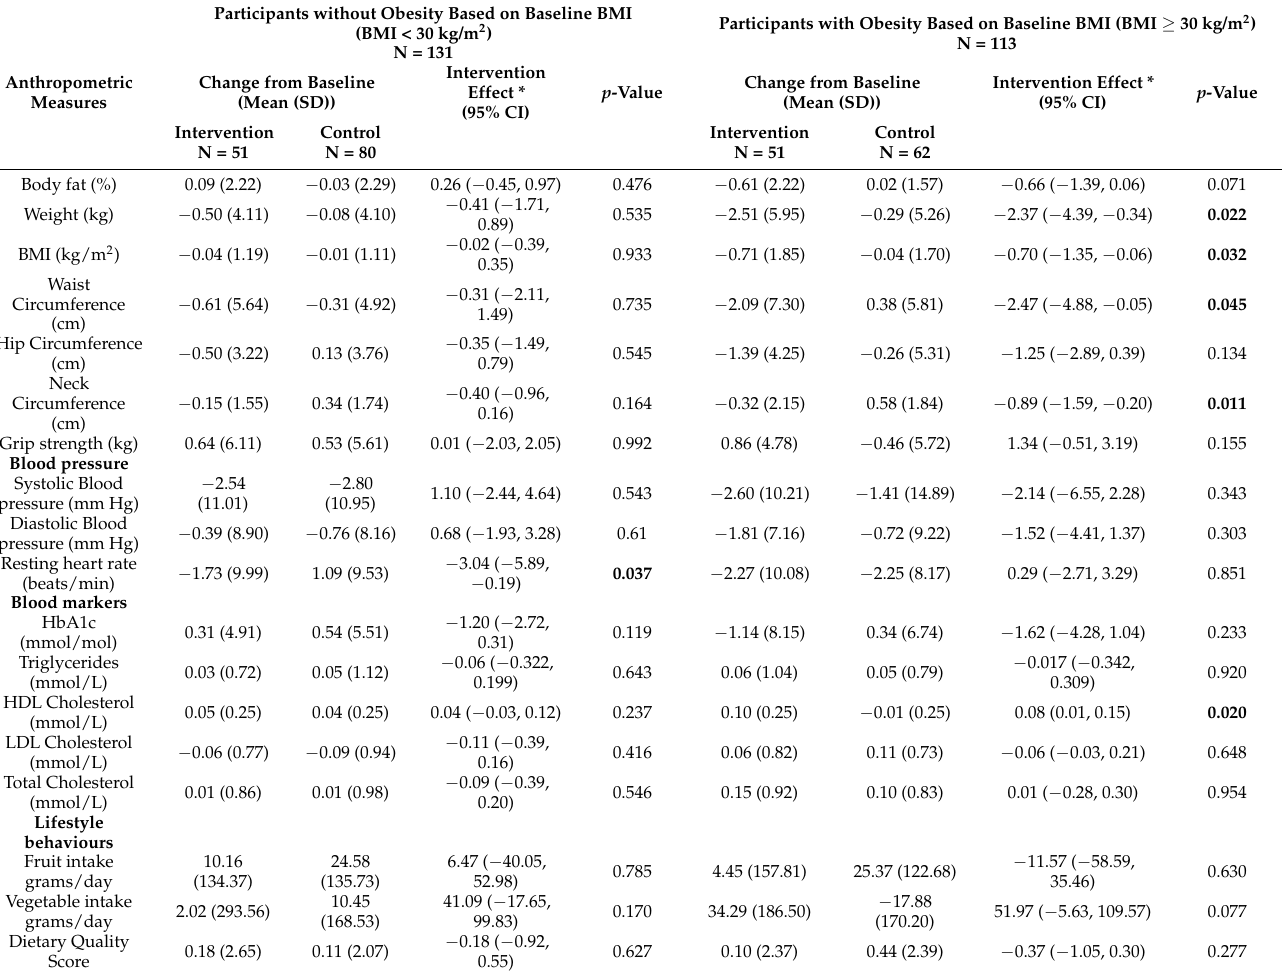
Table 3. Cardiometabolic and lifestyle secondary outcome changes from baseline to 6-month follow- up in participants with and without obesity (based on